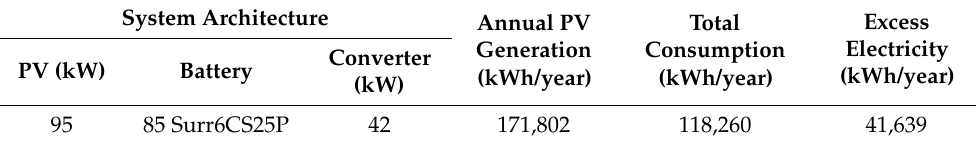
Table 10. PV/battery system report.